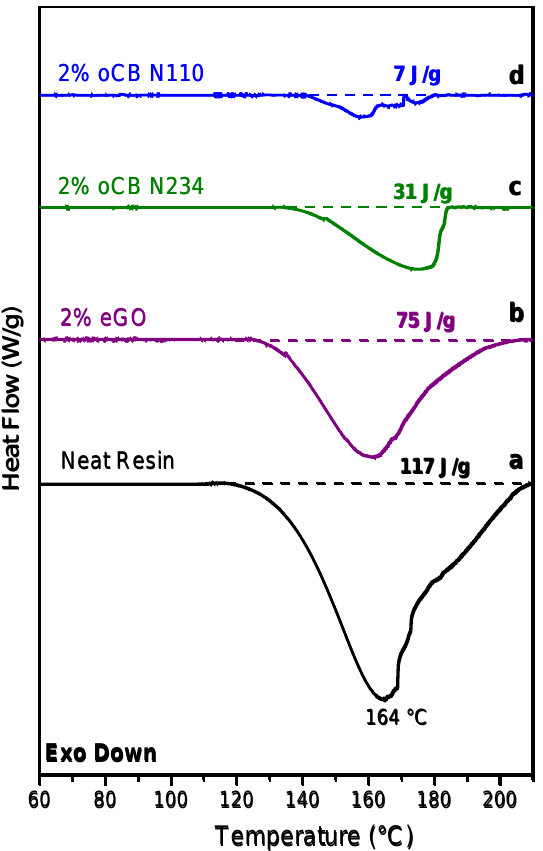
Figure 6. DSC scans at a heating rate of 10 ◦ C / min for resorcinol / HMMM resins (for the weight ratio 1), after isothermal curing at 120 ◦ C for 30 min: ( a ) without filler; ( b – d ) with 2 wt % of carbon filler: ( b ) eGO; ( c ) oCB-N234; and ( e ) oCB-N110. Table 2. Peak positions ( T peak ) and peak shifts ( ∆ T ) taken from dynamic DSC scans like those of Figures 3 and 4. Residual crosslinking enthalpies after isothermal treatment at 120 ◦ C for 30 min ( ∆ H res ), as taken by DSC scans like those of Figure 6. Degree of crosslinking ( α ) after the considered isothermal treatment was calculated from ∆ H res by using Equation